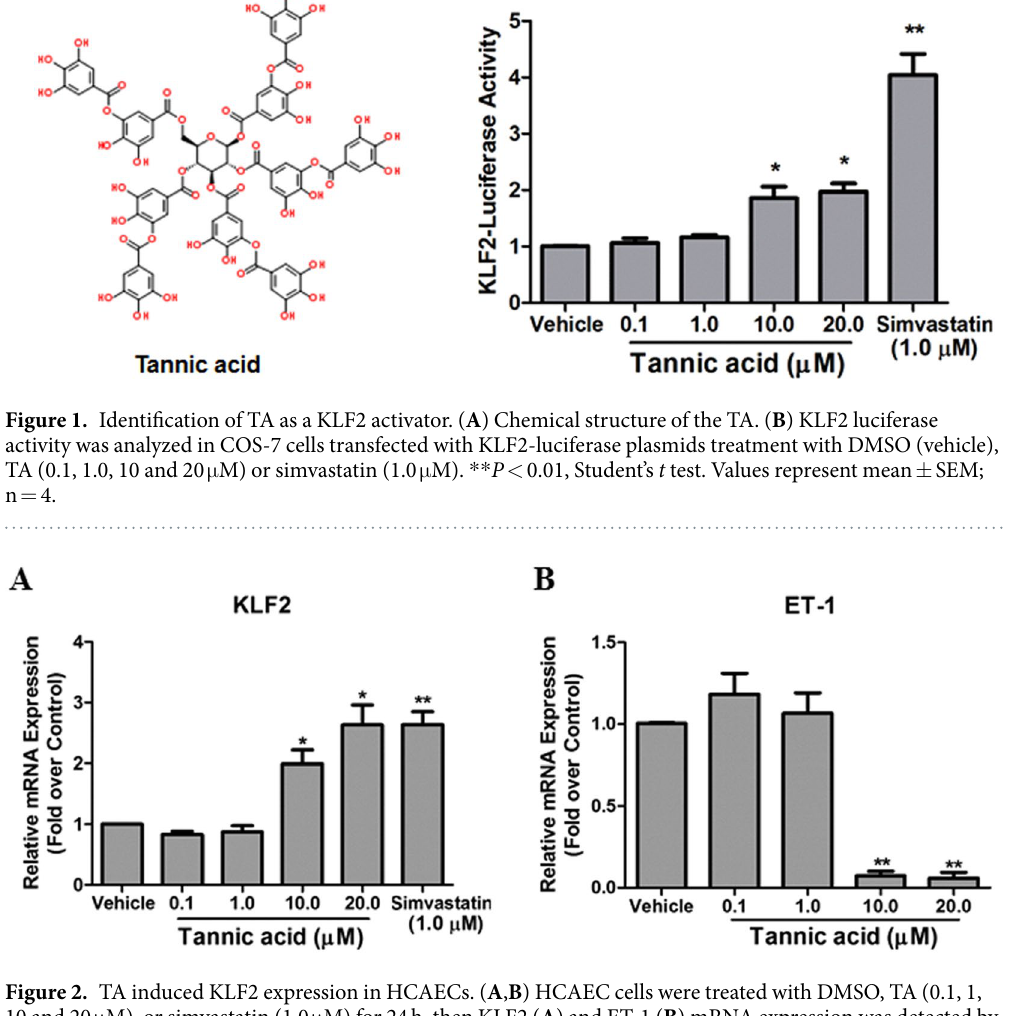
Figure 2. TA induced KLF2 expression in HCAECs. ( A , B ) HCAEC cells were treated with DMSO, TA (0.1, 1, 10 and 20 μ M), or simvastatin (1.0 μ M) for 24 h, then KLF2 ( A ) and ET-1 ( B ) mRNA expression was detected by qPCR. ** P < 0.01, * P < 0.05 (TA or vs vehicle), Student’s t test. Values represent mean ± SEM; n =